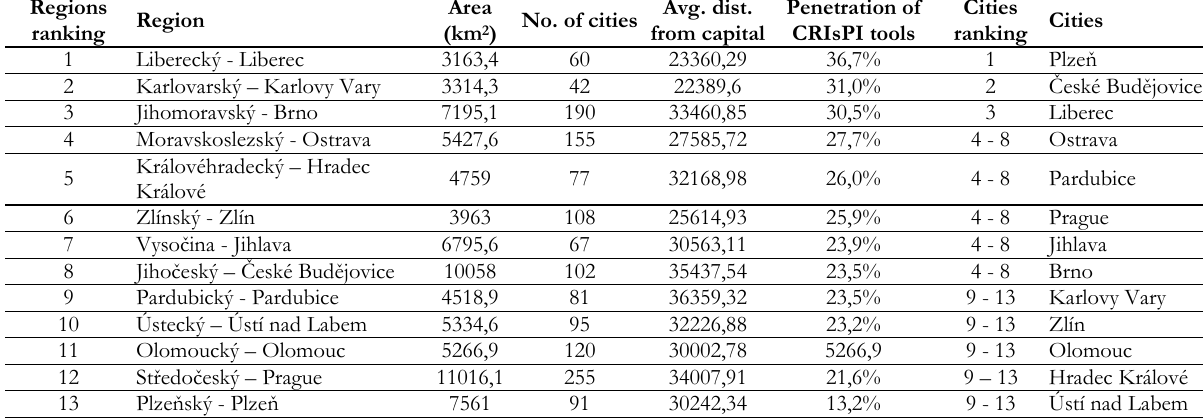
Figure 6. Regions and regional capitals of the Czech Republic Table 3. Ranking of regions in comparison to the ranking of